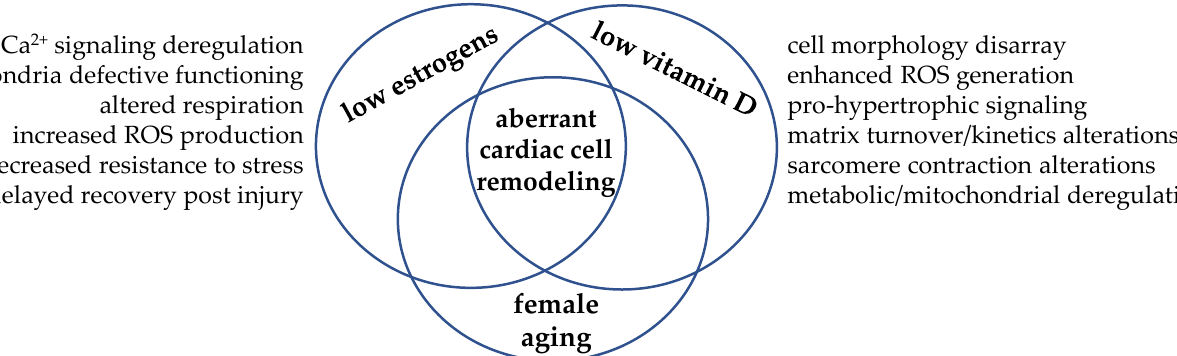
Figure 4. Hypoestrogenism and hypovitaminosis D may intersect in the cardiomyocyte and drive aberrant remodeling. The simultaneous low level of these steroid molecules—a typical hormonal condition experienced post menopause—allows biomolecular aberrant signaling and cell maladaptative response. As these hormones often share the same biomolecular signaling, the hypothesis of interdependent synergic actions within the cardiomyocyte has taken place .